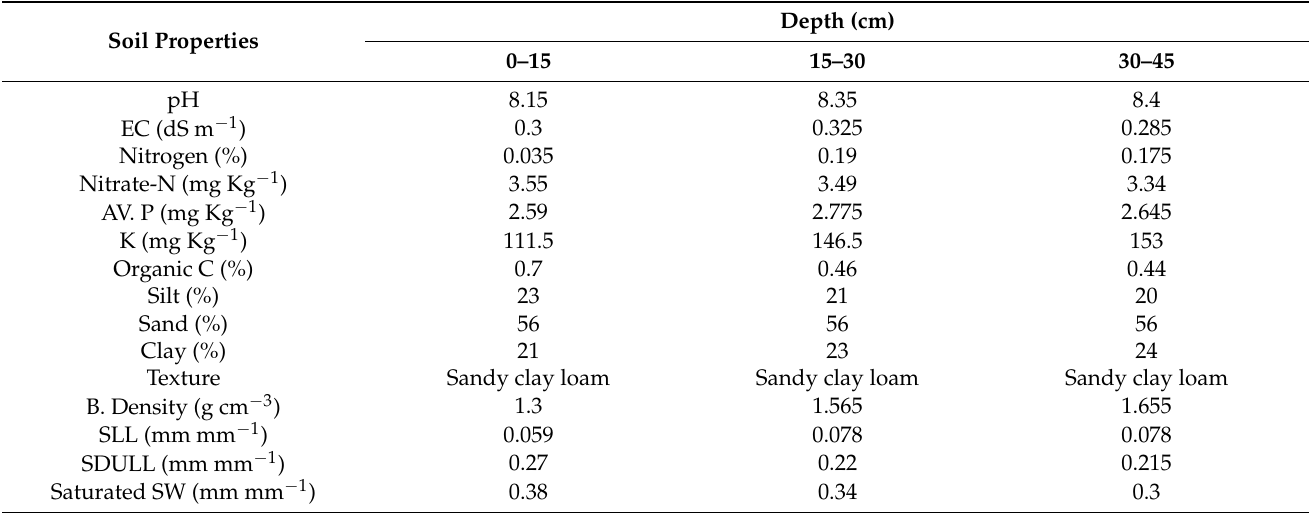
Table 2. Averaged soil physiochemical analysis for two years (2013–2014 and 2014–2015) experiments conducted at Koont research